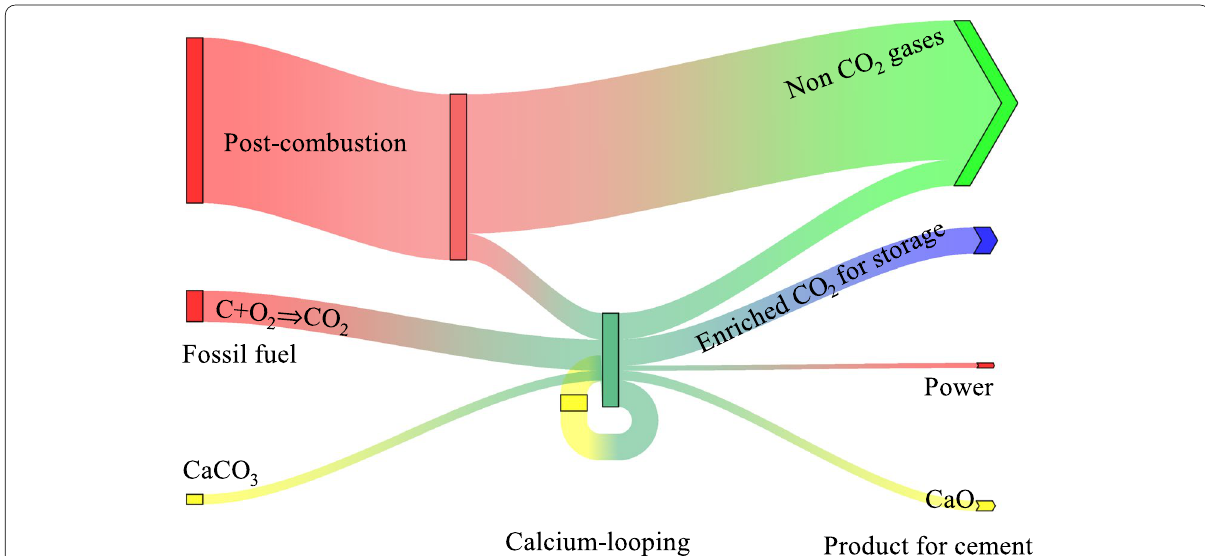
Fig. 5 Schematic of the energy flows of calcium-looping integrated system for post-combustion CO 2 capture and cement manufacture